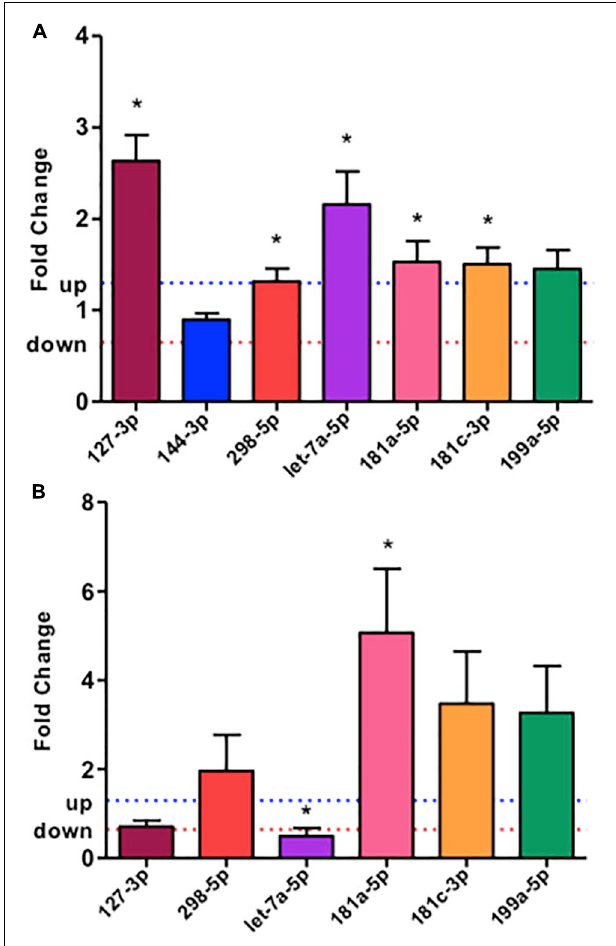
FIGURE 3 | Expression of miRNAs in the LP kidneys from 21 GD (A) and 7DL (B) rats compared to the level of expression in the NP group. The expression of each miRNA was normalized with U6 and U87. The cutoff point variation of 1.3 (upwards) or 0.65 (downwards) was established, and data are expressed as fold change (mean ± SD, n = 4) concerning the control group. * p ≤ 0.05: statistical significance versus